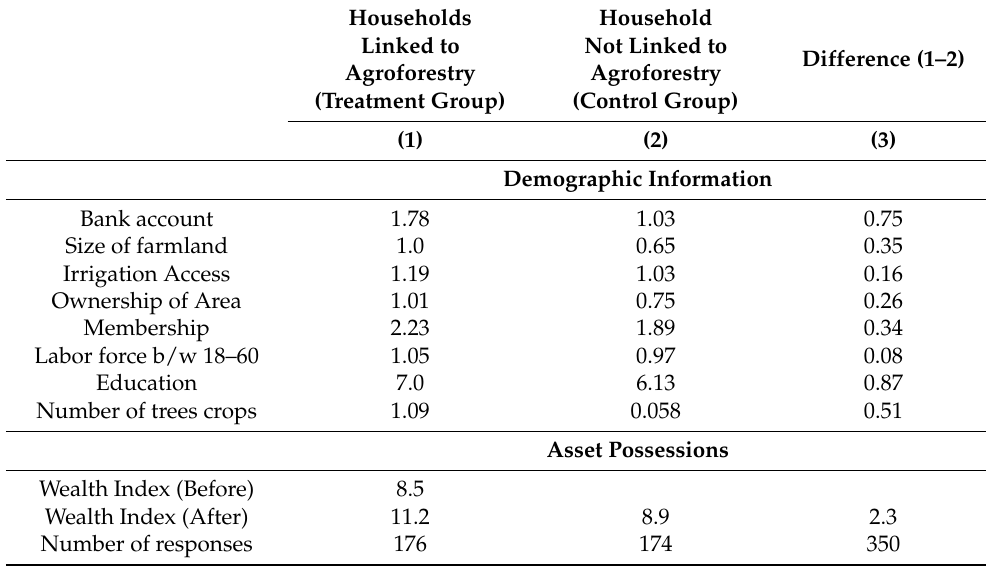
Table 1. The difference in the household between households linked with small scale agroforestry and households not linked with agroforestry.